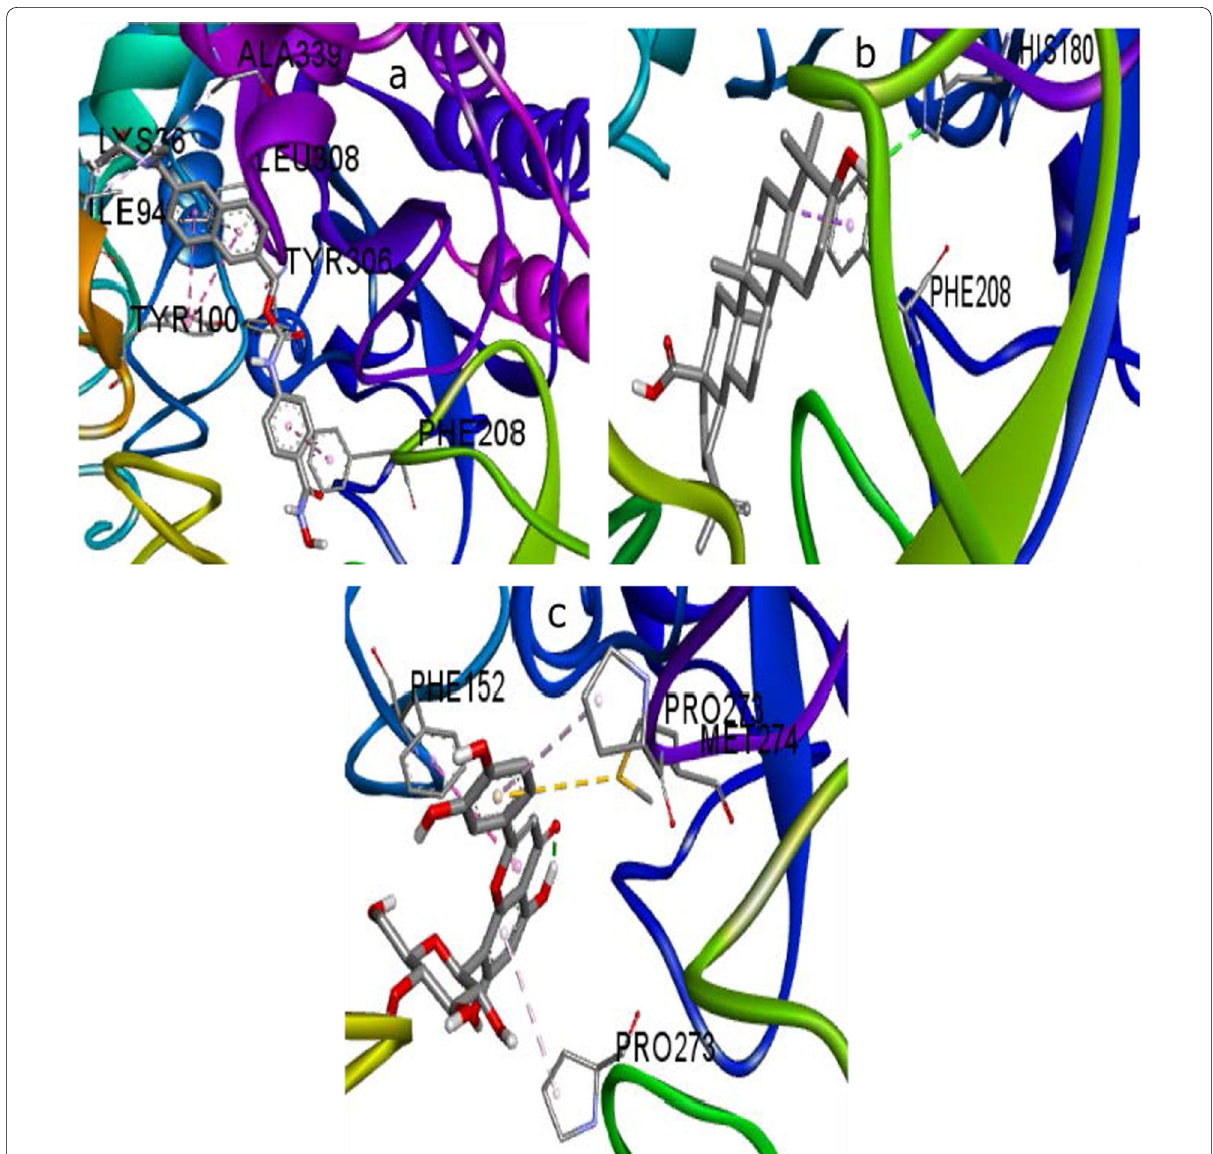
Fig. 5 3D view of the interaction between a givinostat b betulinic acid c orientin and the binding sites in histone deacetylase